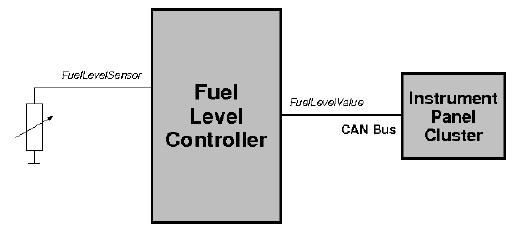
Figure 3. Functional diagram of a fuel level control system